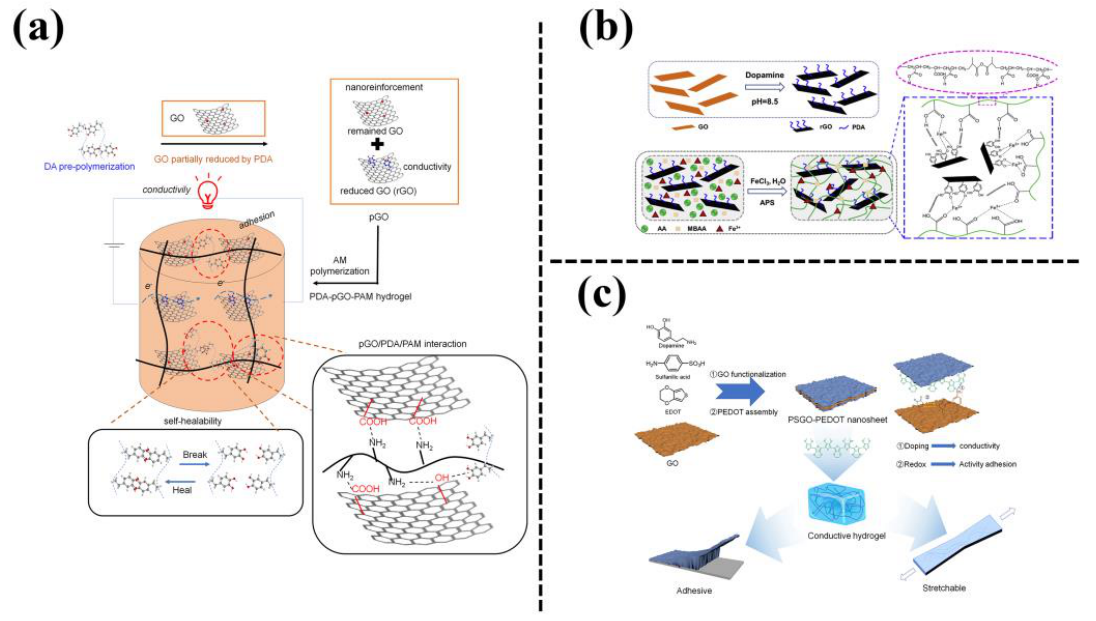
Figure 15. ( a ) Preparation of a conductive, self-adhesive, and self-healable hydrogel by introducing PDA-partially-reduced GO (pGO) nanosheets into a PAM hydrogel [106]. ( b ) Incorporating pGO into a PAA network to form a mussel-inspired conductive nanocomposite hydrogels [107]. ( c ) Fab- rication of the hydrophilic, conductive, and redox-active sandwich-like PSGO-PEDOT nanosheet and its incorporation into a PAM network to form a hydrogel with high conductivity, adhesiveness, and stretchability